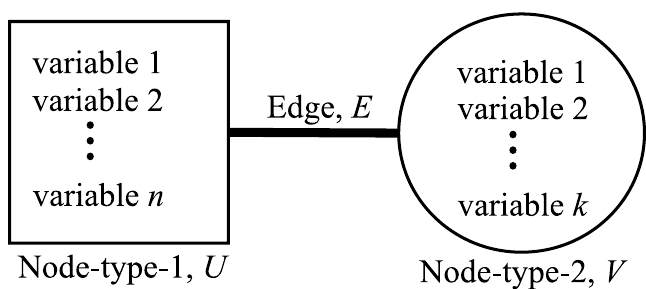
Fig. 2 Representation of basic building